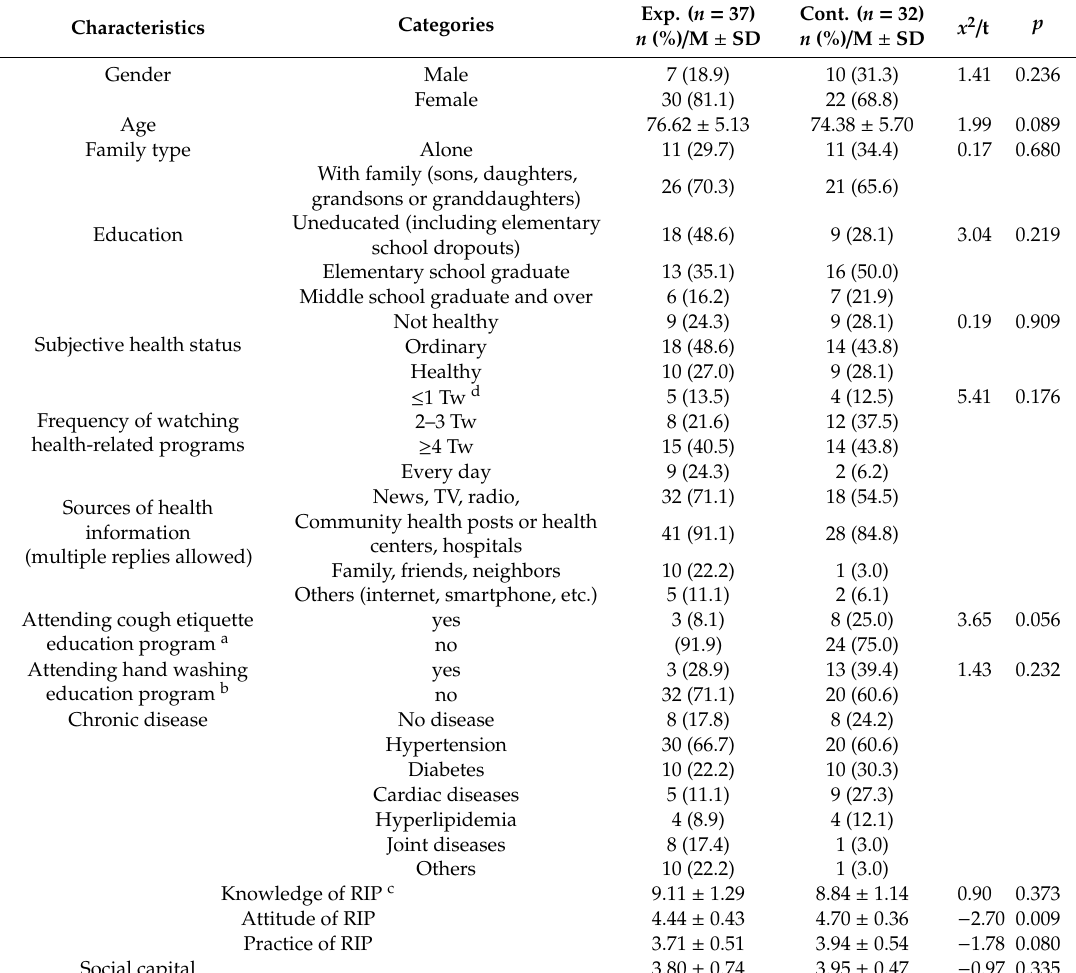
Table 3. Results of homogeneity testing ( N =